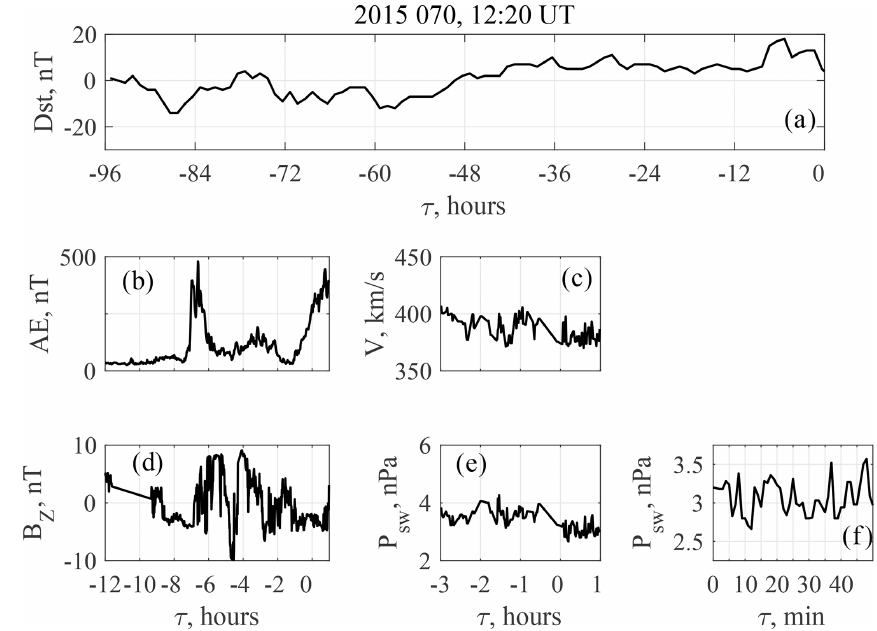
Figure 5. Space weather conditions for event 1. (a) Dst index during last 4d; (b) AE index during the interval and 12h before; (c) SW speed during the interval and 3h before; (d) IMF B Z during the interval and 12h before; (e) SW dynamic pressure during the interval and 3h before; (f) details of SW dynamic pressure fluctuations during the interval.